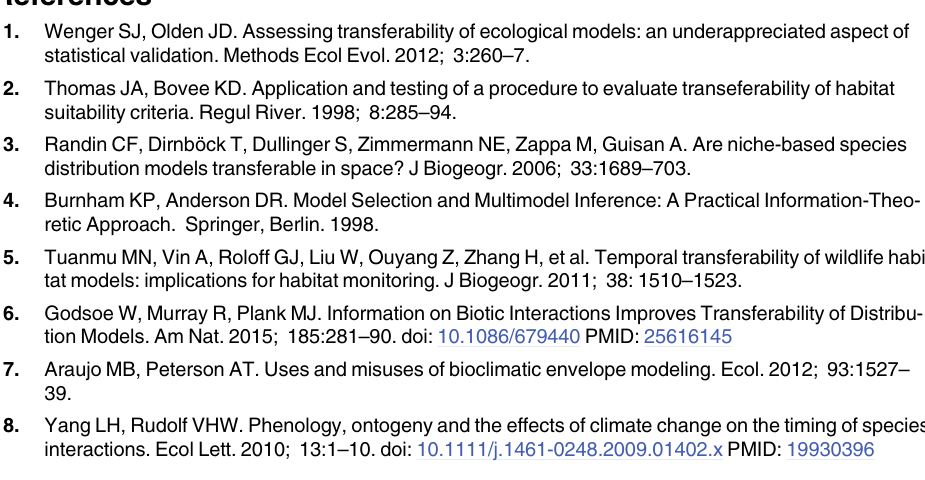
S3 Fig. Cumulative curves of cell numbers where breeding sites of buzzards were detected in five study sites for last three observation-years. S4 Fig. Average nearest neighbor distances between gray-faced buzzard nests in five study- sites of Japan. Error bar shows standard error. S1 Table. Proportions in areas of all types of forests and open-fields in five study sites. Pro- portions of deciduous and evergreen broad-leaved and planted coniferous forests within all types of forests, and those of paddy fields and grasslands within open-fields are also shown. S2 Table. Maximum numbers of used-cells, numbers of breeding nests in a year when the used-cells were the maximum, number of studied cells, and year when the used-cells were maximum in each study